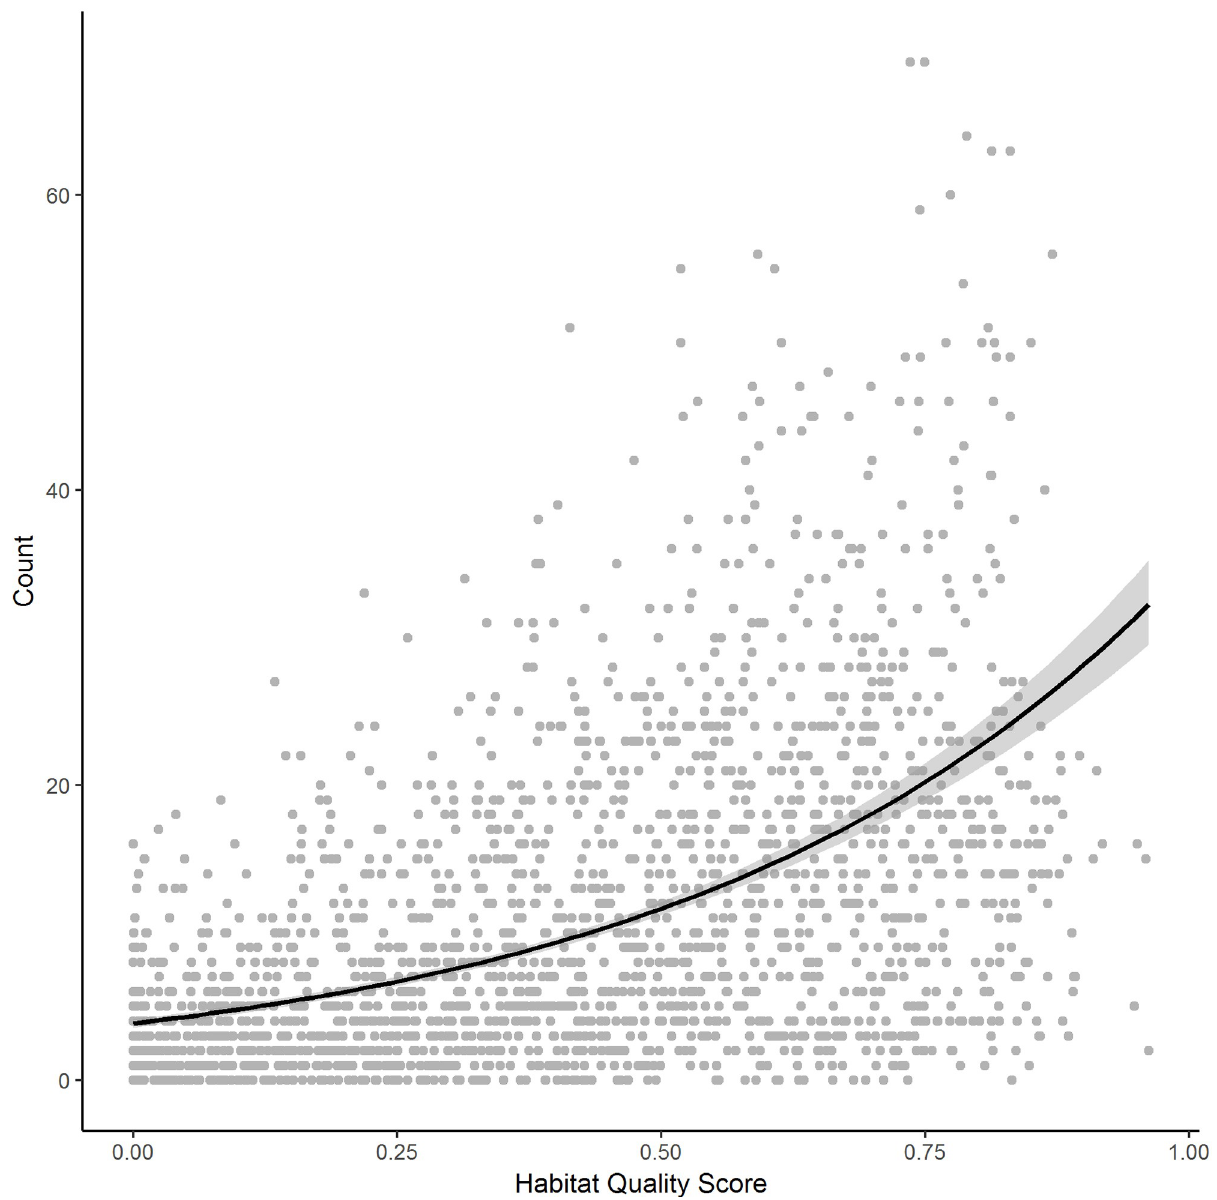
Fig 2. Scatter plot of habitat-quality rating versus bird abundance (with 95% confidence interval band) for 2100 points surveyed during the 2013– 2015 North American Breeding Bird Survey.